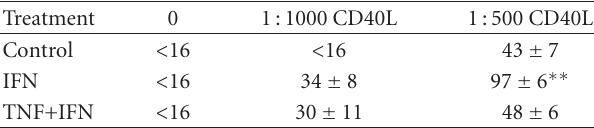
Table 1: Il-12 p40 protein in the cell culture medium measured by ELISA